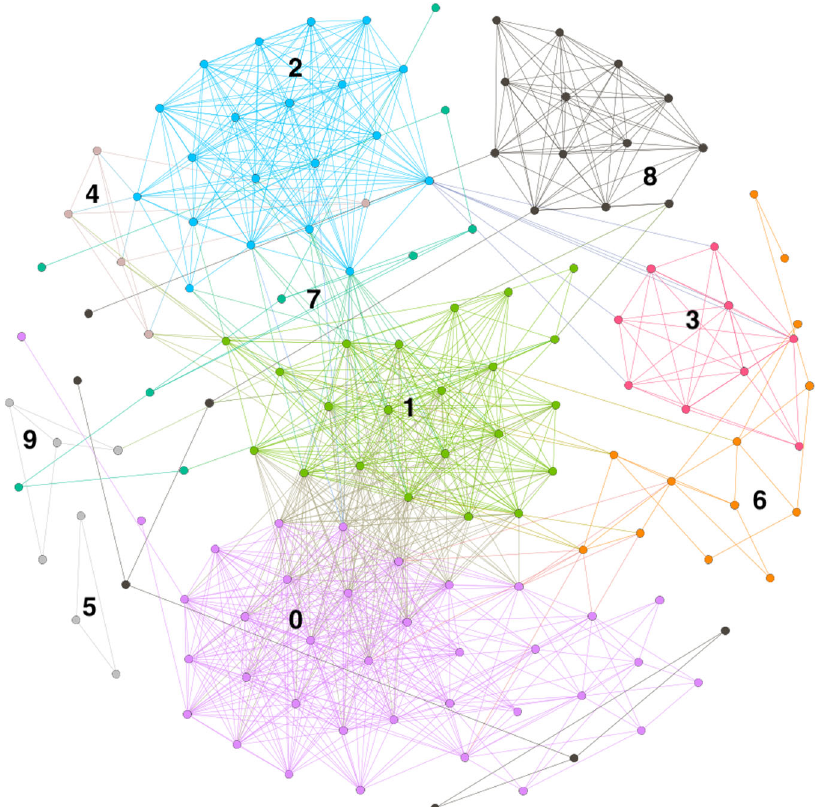
Fig. 2 Veganuary 2019 projection network. Shows the network community structure of users with overlapping sets of retweeting users. Ten distinct communities emerge. They are labelled arbitrarily with digits. These digits match those found on the right hand side of Fig.